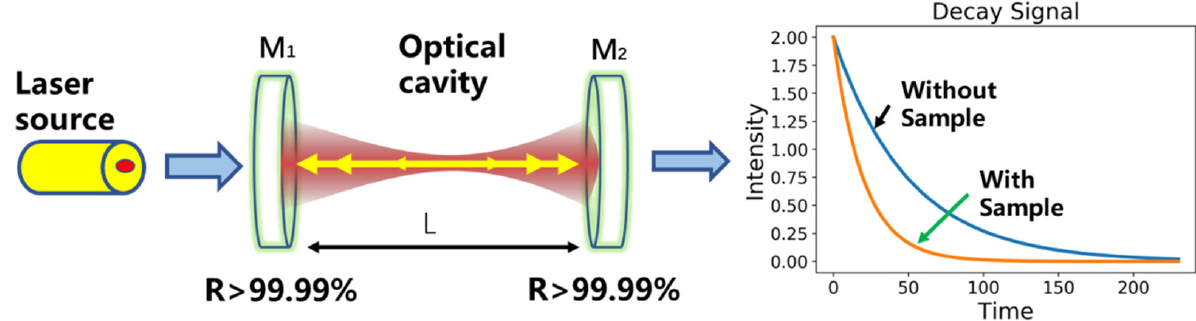
Figure 1. Schematic of the cavity ringdown technique. M 1 and M 2 : cavity mirrors with high reflectivity (>99.99%).